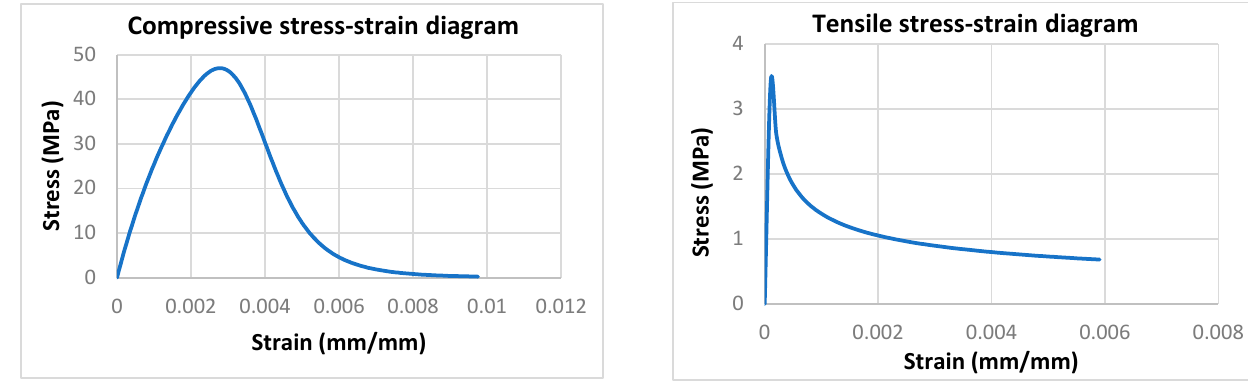
Figure 7. Compressive and tensile stress–strain diagrams for high strength concrete (f’c = 47 MPa).